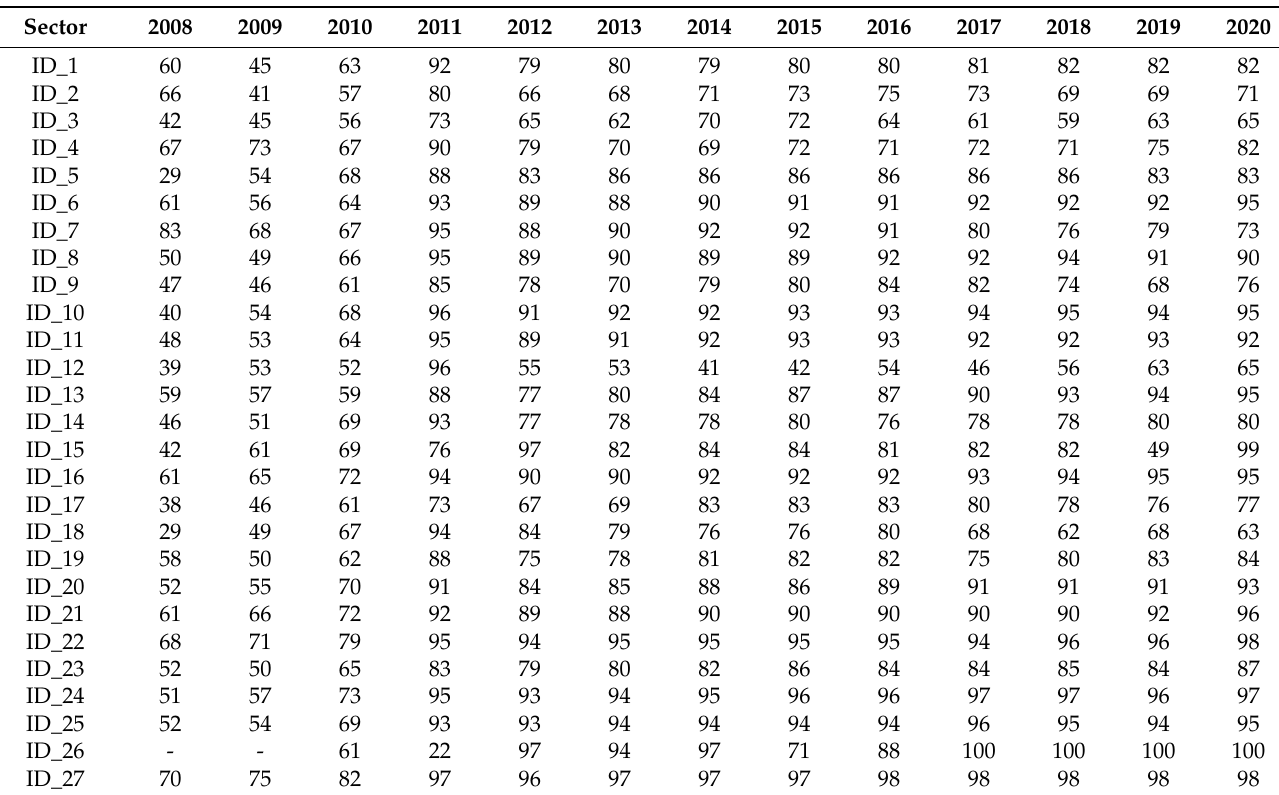
Table 5. The proportion of CO 2 emissions embodied in electricity to total emissions in 27 manufac- turing subsectors (%).